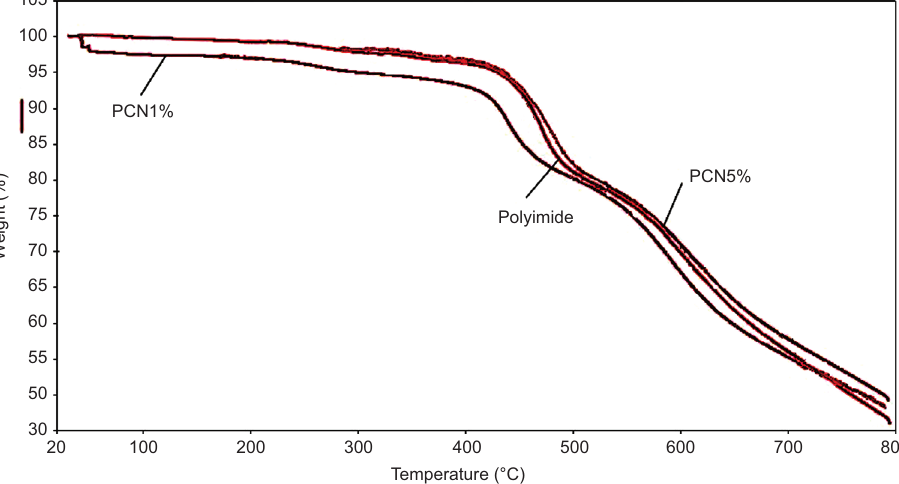
Figure 4 Comparison between thermal gravimetric thermograms of PI, PCN1%, and PCN5%.